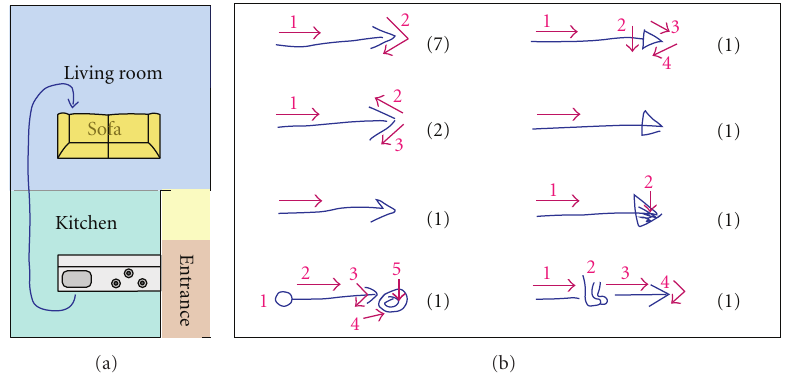
Figure 8: Sketch notations for movement between regions using